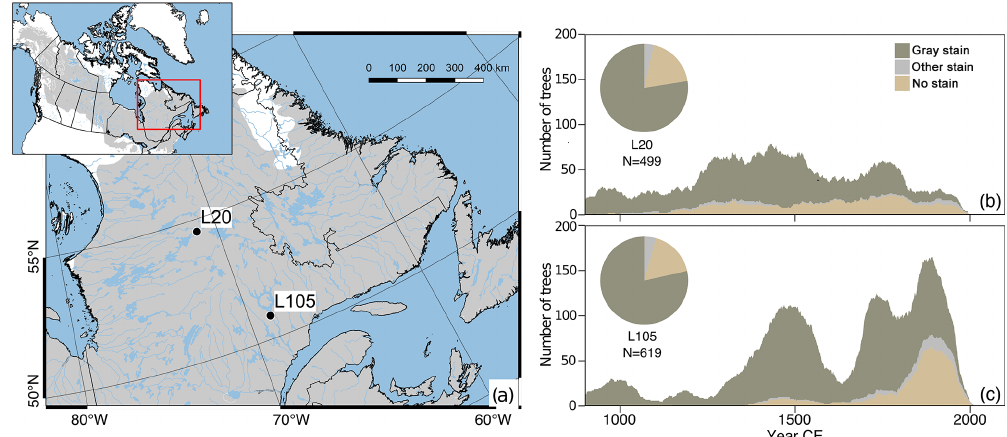
Figure 1. Location of the two studied lakes (a) , and frequency of cross-dated LSTs according to staining at L20 (b) and L105 (c) . The gray shading in (a) corresponds to the distribution range of black spruce (map source available at https://www.fs.fed.us/database/feis/pdfs/Little/ aa_SupportingFiles/LittleMaps.html, last access: 15 September 2020). The “other stain” category includes a variety of additional colors such as red or dark